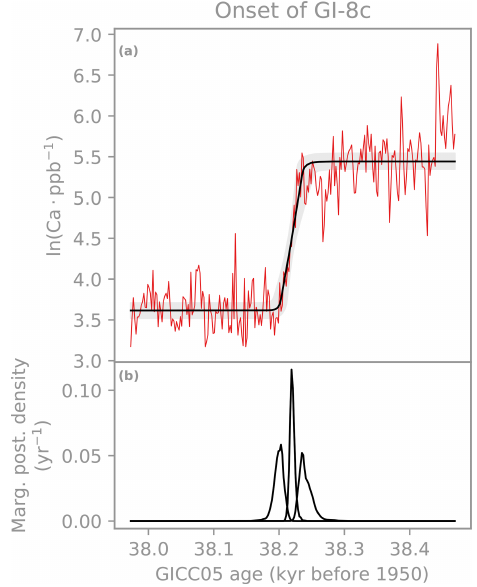
Figure 2. Example of a fitted ramp for the Ca 2 + data from the onset of GI-8c. Panel (a) shows the data together with the marginal poste- rior median of the fitted ramp (thick black line). Shaded areas indi- cate the marginal posterior 5th and 95th percentiles. Panel (b) shows the marginal posterior densities for the onset, midpoint and endpoint of the transition (from right to